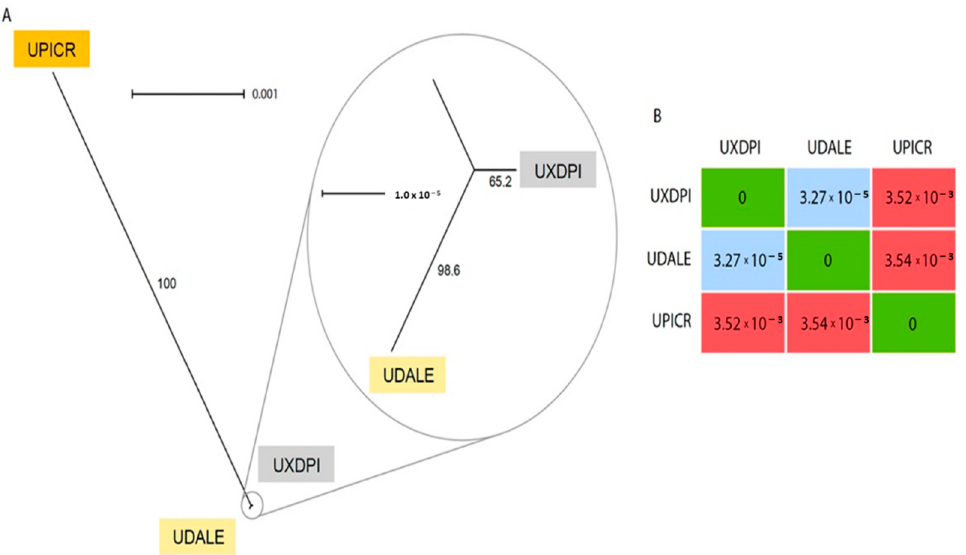
Figure 4. ( A ) Neighbor-Net splits graph based on uncorrected p-distances of the chloroplast matrix of U. dalechampii (UDALE), U. picroides (UPICR) and U. dalechampii × U. picroides (UXDPI). Numbers in branches indicate bootstrap support. ( B ) Distance matrix of the three taxa included in the analysis.